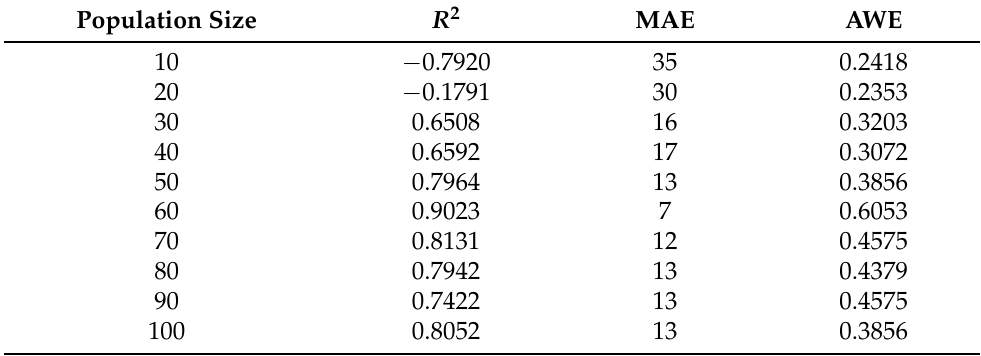
Table 6. The population size adjustment evaluation table of the hyperparameters in the GA-BP